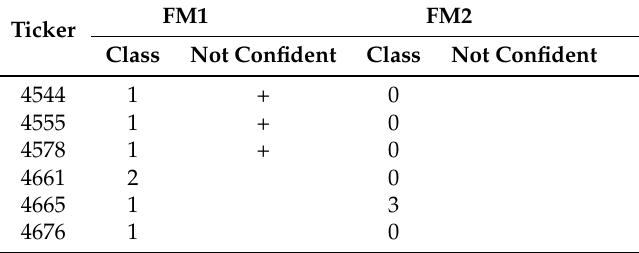
Table 4. Portion of evaluation data from fund managers. “+” means they were not confident in their classification for certain company. FM1 FM2 Ticker Not Confident Not